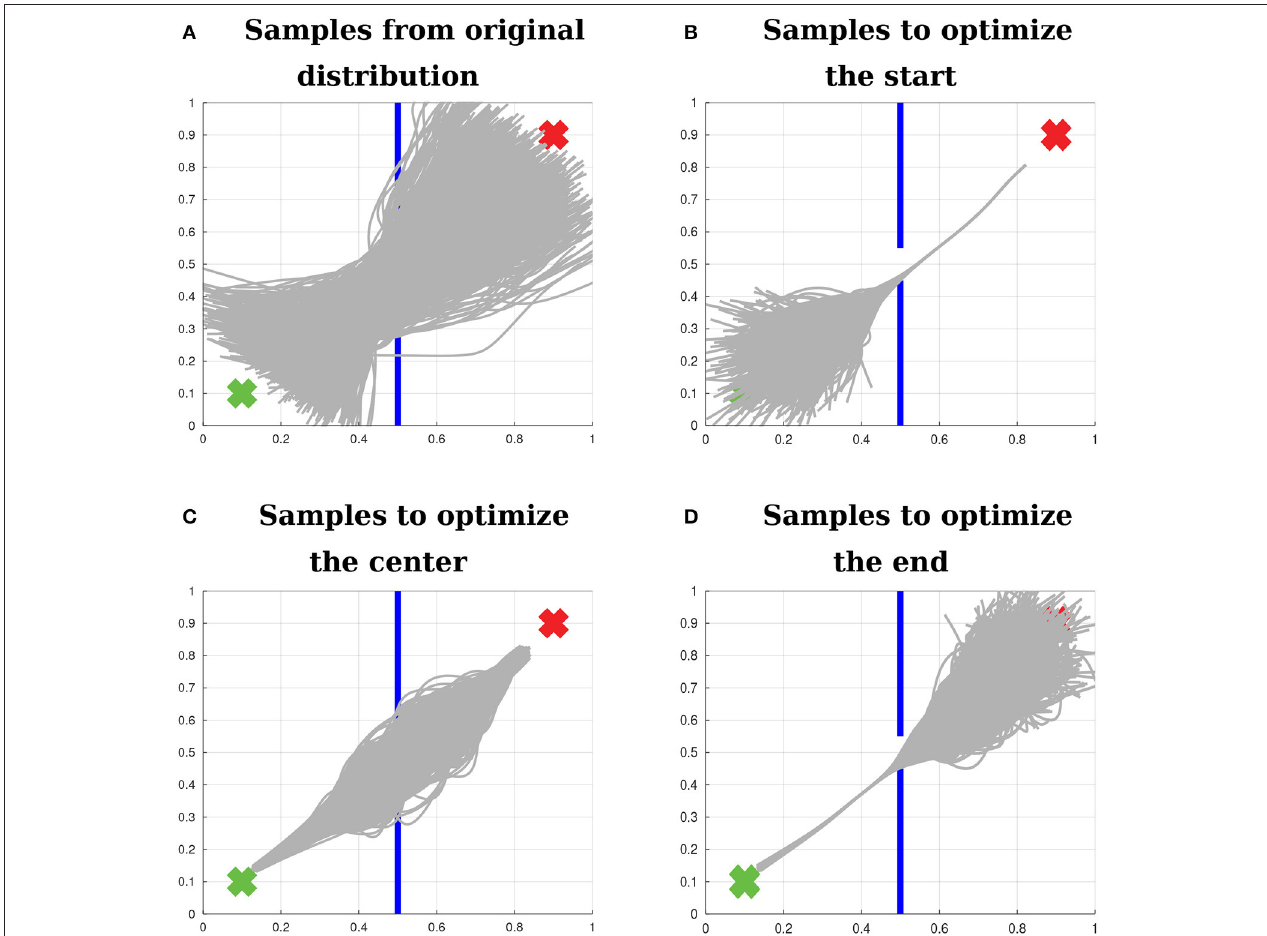
FIGURE 9 | Sampling with relevance weighting. (A) Samples from the original distribution. (B) Samples to optimize the distribution over trajectories with respect to beginning at the start position. (C) Samples to optimize the distribution over trajectories with respect to passing through the center of the window. (D) Samples to optimize the distribution over trajectories with respect to reaching the end position. The proposed algorithm explores for each objective a large range of values for the policy parameters that are relevant to that objective, while sampling values close to the mean for the other policy parameters. The variance of the irrelevant parameters is recovered according to Equation (43). Therefore, after optimizing for each objective, the distribution over the relevant parameters is updated, while the distribution over the irrelevant parameters is preserved.